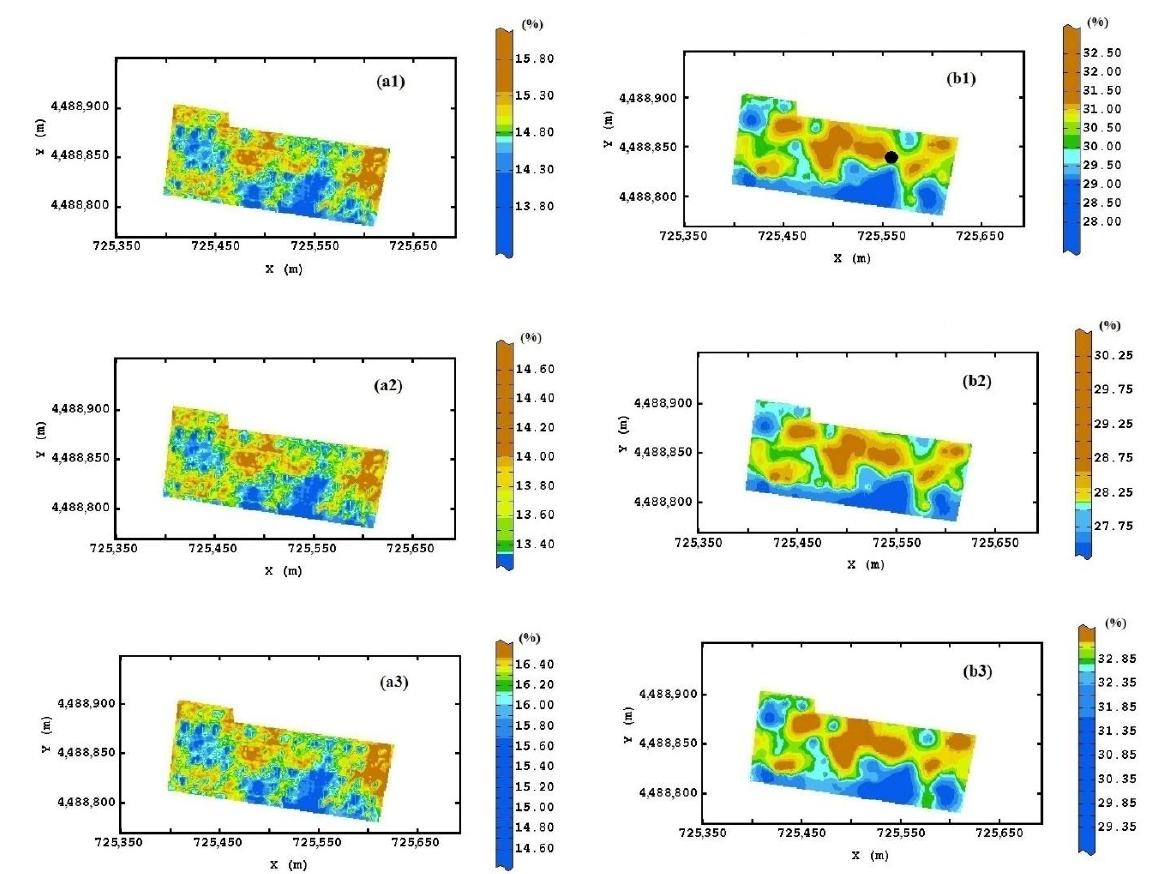
Figure 8. The raw data maps of clay ( a1 ) and silt ( b1 ) with their respective lower limit ( a2 , b2 ) and upper limit maps ( a3 , b3 ). In ( b1 ), the position of the reference spectrum is shown (dot). Colour scale uses isofrequency classes.